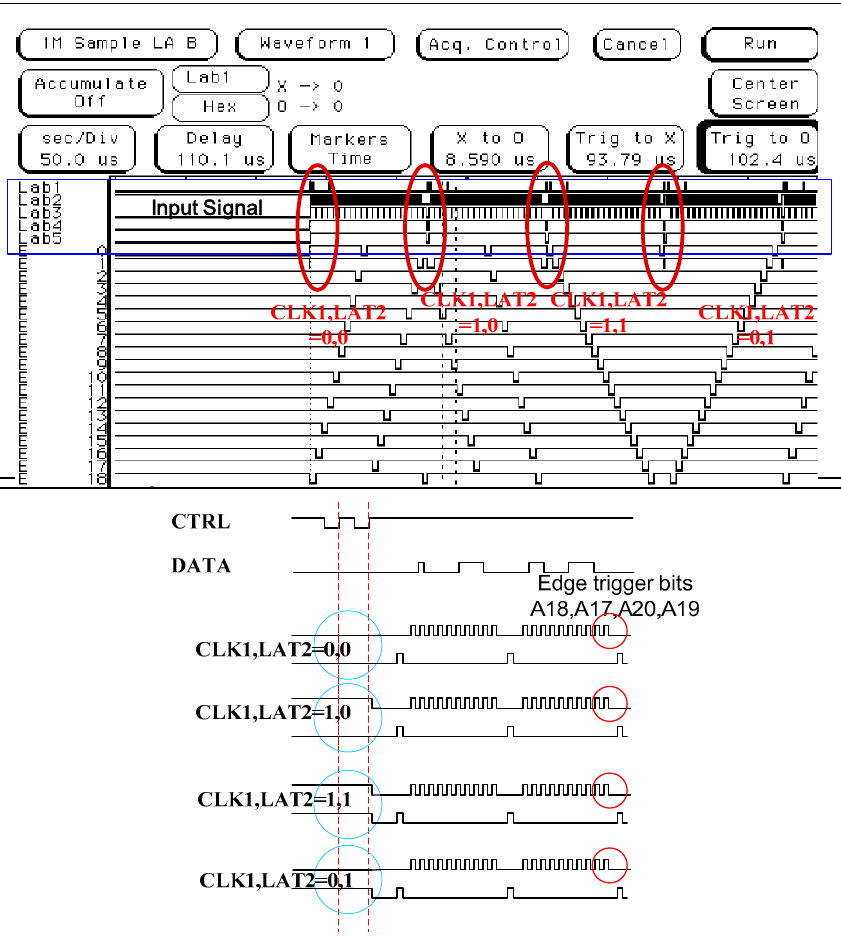
Figure 3. Entire 16 × 28 thermal resistance thin film control driver circuit signal and field programmable gate array verification result.